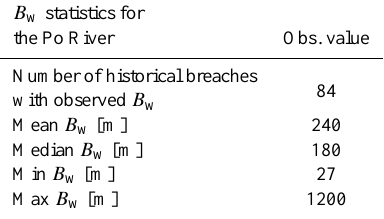
Table 2. Width of dike breaches, B w : statistics observed along the Po River in the period 1800–1951 (data from Coratza,